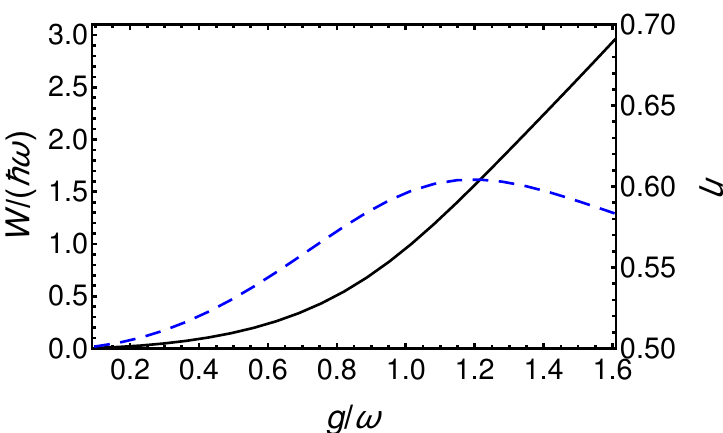
Figure 2. This graph shows the extracted work (solid black line), W / ( ¯ h ω ) , and the ideal efficiency (dashed blue line), η , as a function of the coupling parameter g / ω , for the Rabi model at T =